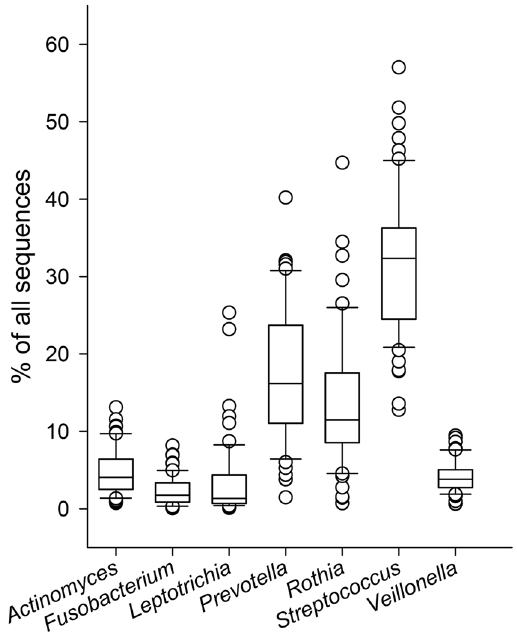
Figure 2. Box plot of genera present in both saliva and tooth biofilm and in all participants. Data are % of all sequences (abundance) in saliva. The bottom and top of the box indicate the first and third quartiles, the line inside the box the median, and the ends of the whiskers the 10th and the 90 th percentile values. Outliers are plotted as individual